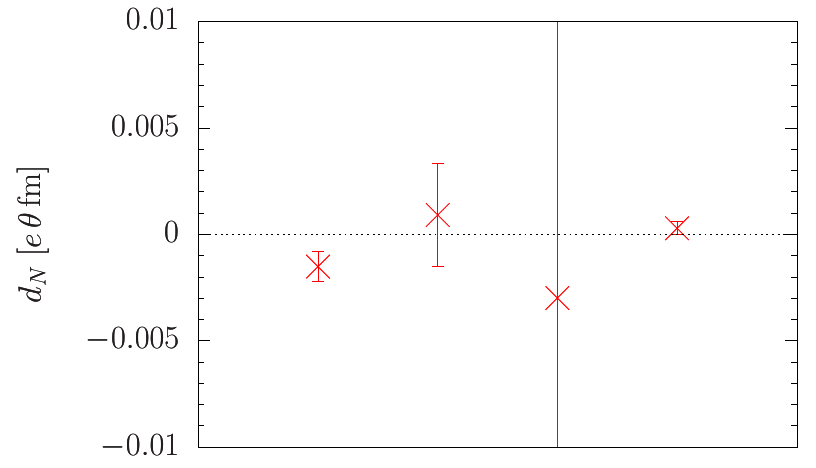
Figure 10: The electric dipolemoment of the neutron from Refs. [ 24 ] , [ 25 ] , [ 26 ] and [ 27 ] , from left to right.